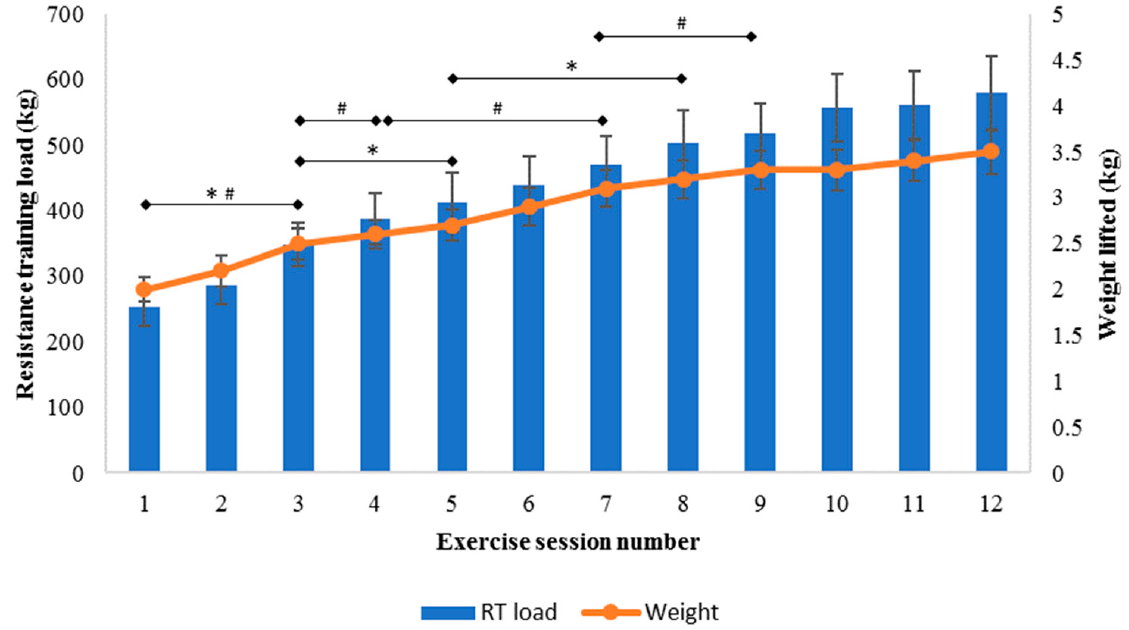
Figure 4. Resistance training (RT) prescription during 12 sessions of cardiac rehabilitation. Data presented as mean (95% CI). * Significant progression in resistance training load, # significant progression in weight lifted during resistance training.